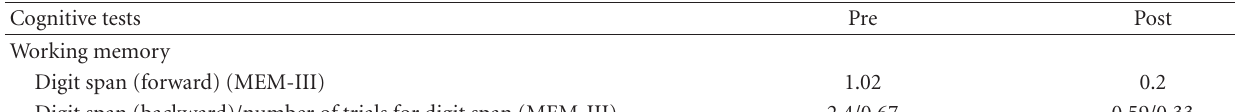
Table 2: G. O.’s results on cognitive